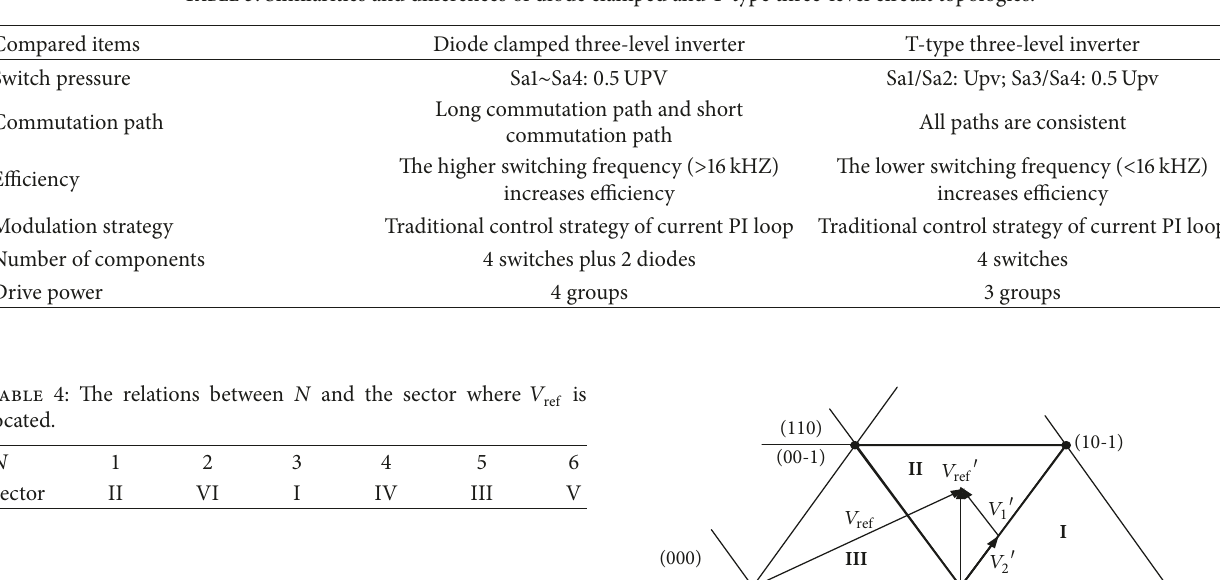
Table 3: Similarities and differences of diode clamped and T-type three-level circuit topologies.